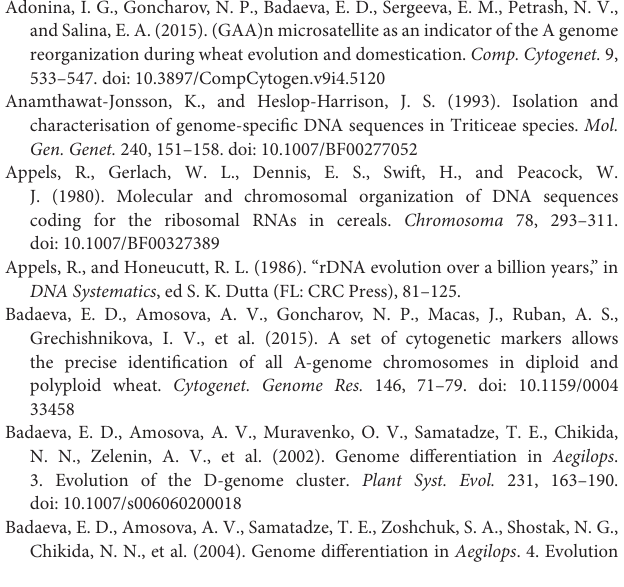
Figure S3 | C-banding polymorphism of Ae. peregrina (a–f) and Ae. kotschyi (g–j) chromosomes: (a) , TA1888; (b) , C11 (Nahal Mearot, Israel); (c) , K-61; (d) , C12 (Caesaria, Israel); (e) , C13 (Natufia, Israel); (f) , i-570632; (g) , PI 487279; (h) , K-91; (i) , TA2206; (j) , K-201; (k) K-2905. 1–7, homoeologous groups. Table S1 | List of material and their